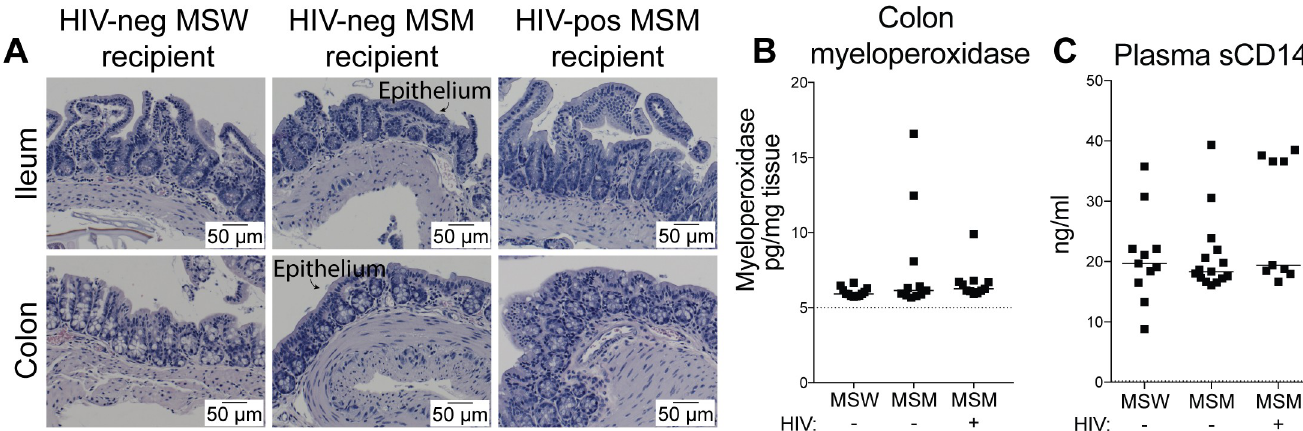
Fig 5. Absence of inflammation, epithelial damage, and bacterial translocation in mouse recipients. (A) Formalin-fixed ileum and colon sections from mouse recipients (5 HIV-negative MSW, 7 HIV-negative MSM, 6 HIV-positive MSM) were paraffin-embedded and H&E stained, and then analyzed by a blinded pathologist for inflammation and epithelial integrity. Representative images of ileum and colon tissue are shown. Arrows point to the epithelium. All tissues analyzed were scored with the minimal inflammation rating of 1, on a scale of 1–4. (B) Myeloperoxidase concentrations measured by ELISA in colon tissues (12 HIV-negative MSW, 11 HIV-negative MSM, 11 HIV-positive MSM). (C) sCD14 levels measured by ELISA in plasma (11 HIV-negative MSW, 15 HIV-negative MSM, 9 HIV- positive MSM). For (B) and (C), each data point represents an individual mouse, lines represent medians, dotted lines represent the limit of detection. Statistical analyses were performed using t-tests to compare groups if data from both groups had normal distributions and Mann-Whitney tests to compare groups if data from at least one group had a non-parametric distribution. No statistically significant differences were detected.